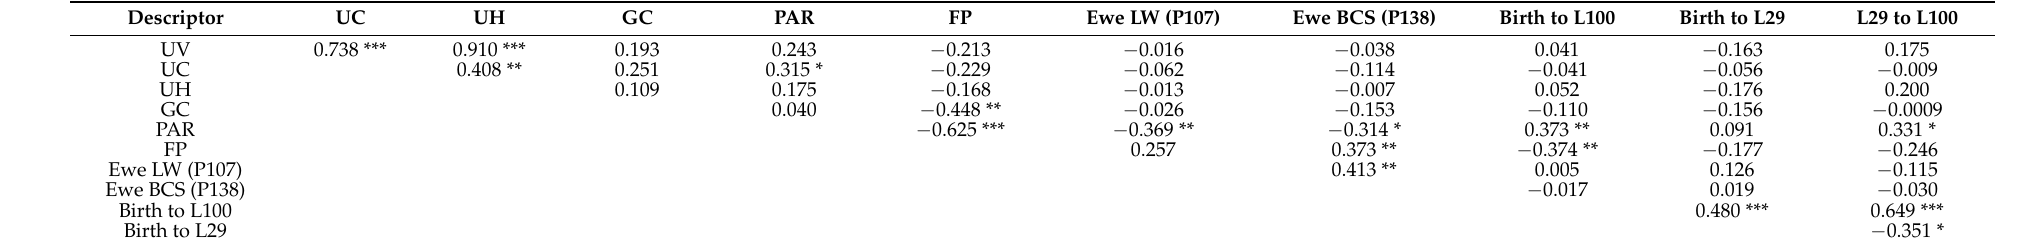
Table 4. Correlation coefficients of residuals of udder volume (UV), circumference (UC), height (UH), gland cistern (GC), parenchyma (PAR) and fat pad (FP) at P107, live-weight of yearling ewes (Ewe LW) in pregnancy (P107) 1 , body condition score of yearling ewes (Ewe BCS) in late pregnancy (P138), lamb growth from birth to weaning (Birth to L100), birth to early lactation (Birth to L29) and early lactation to weaning (L29 to